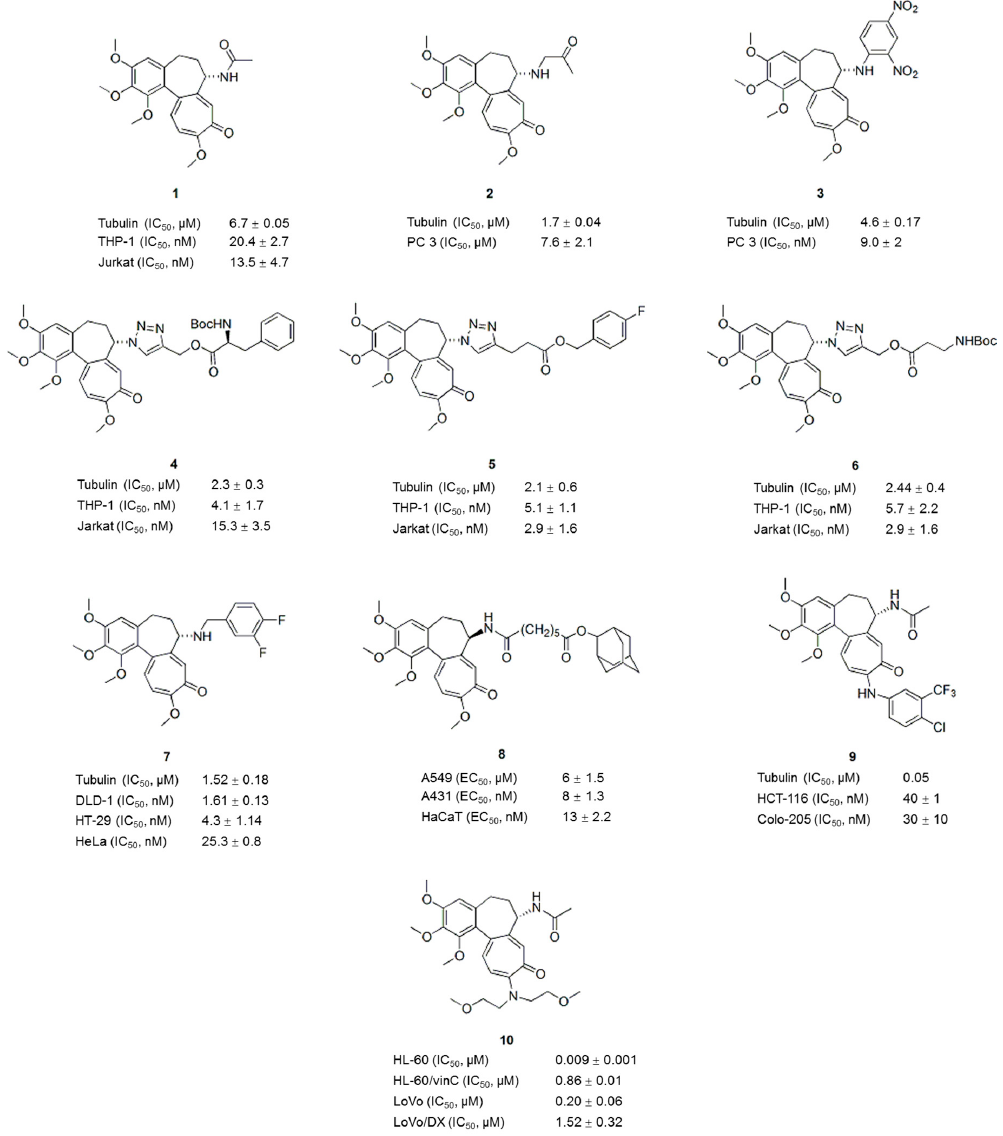
Figure 2. Structures of colchicine derivatives.